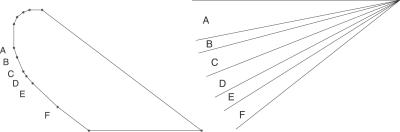
The Alignment Polygon for Our Two Introns Is Shown on the LeftFor each of the alignment summaries A,B, . . . F in Table 1, the corresponding cone in the alignment fan is shown on the right. If the parameters (S,X) stay inside a particular cone, every optimal alignment has the same alignment summary.